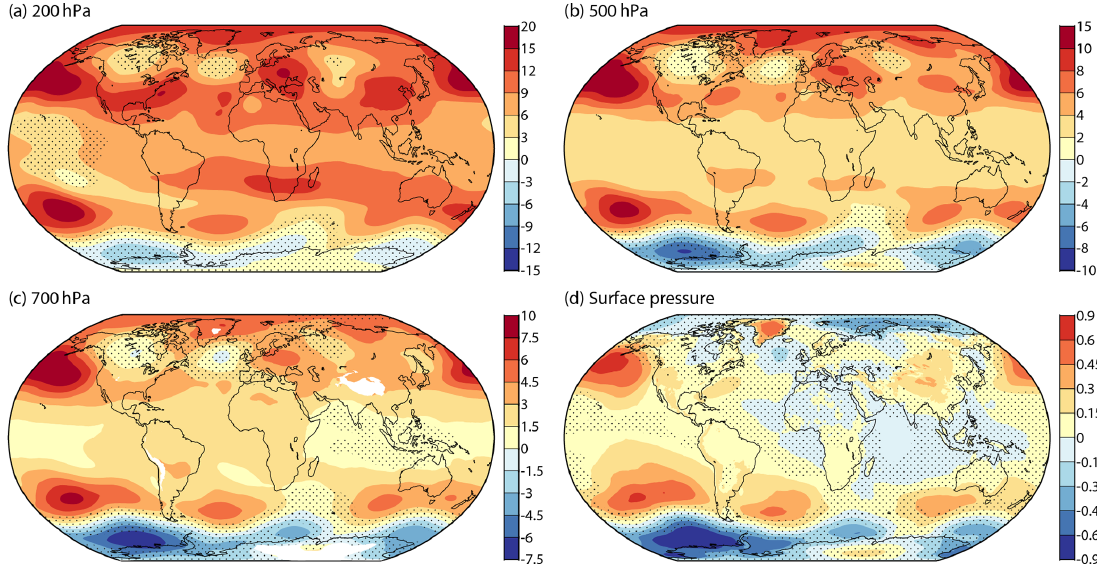
Figure 20. Trends in geopotential height (m per decade) and surface pressure (hPa per decade) derived from least squares linear fits of monthly mean deviations from average values for each month in the period March 1979 to February 2022. (a) 200hPa height, (b) 500hPa height, (c) 700hPa height and (d) surface pressure. Dots show where the 95% confidence interval is two-signed. 700hPa regions where the ERA5 model orography exceeds 3000m are masked in